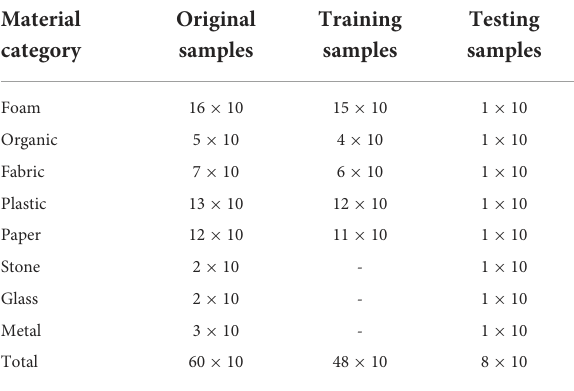
TABLE 2 The details of the dataset splits on the PHAC-2.